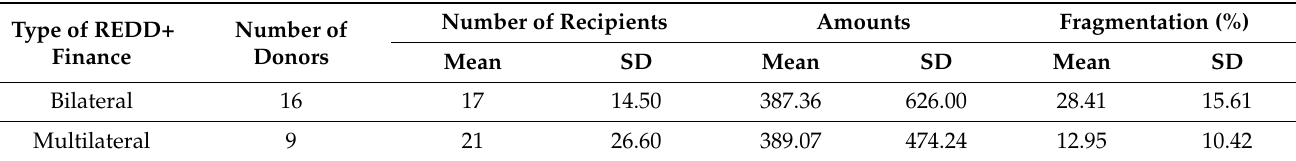
Table 6. Fragmentation of bilateral and multilateral REDD+ finance.